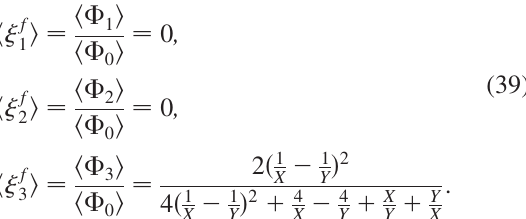
FIG. 7. The average Stokes parameter h (cid:7) f gamma-ray photons produced by 100% horizontally polarized ¼ 1 , P ¼ 0 , (cid:8) ¼ 0 ) 800 nm laser photons head-on colliding ( P t c with an unpolarized 500 MeV